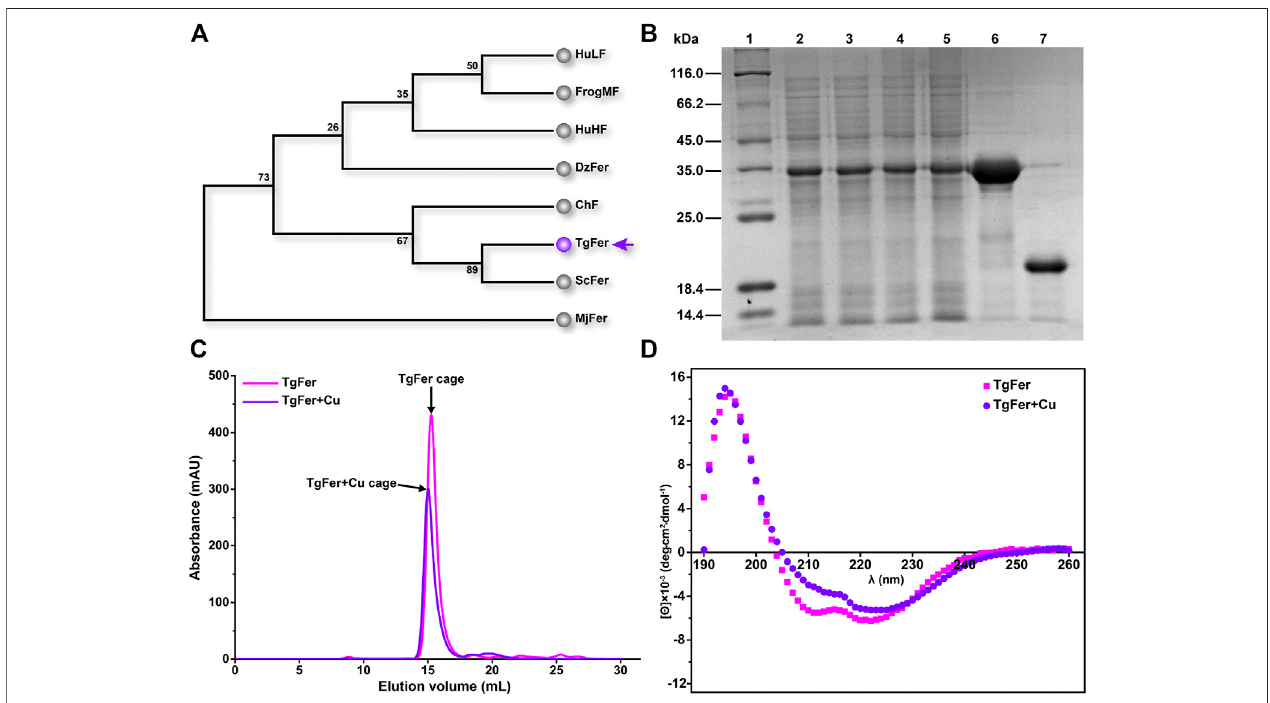
FIGURE 1 | (A) Phylogenetic analysis was performed among eight ferritins from various species. Species abbreviations (with PDB accession ID in parentheses): TgFer, Tegillarca granosa ferritin (6L55); ScFer, Sinonovacula constricta ferritin (6LP5); ChF, Chaetopterus ferritin (5WPN); MjFer, Marsupenaeus japonicus ferritin (6A4U);DzFer, Dendrorhynchuszhejiangensis ferritin(7EMK);HuHF,humanH-chain ferritin(2FHA);BfMF,bullfrogMferritin(4DAS);HuLF,humanL-chainferritin(2FFX). (B) Expression and puri fi cation of recombinant TgFer. Lane 1: middle molecular marker; Lanes 2 – 3: total protein of TgFer induced 18 ° C for 14 h; Lanes 4 – 5: total protein of TgFer induced at 18 ° C for 18 h; Lane 6: puri fi ed TgFer protein; Lane 7: puri fi ed TgFer protein without SUMO tag. (C) Superdex 200 gel- fi ltration chromatography pro fi le of TgFer and TgFer + Cu. The peak of the target protein is shown by a black arrow. (D) Circular dichroism spectra of TgFer and TgFer +